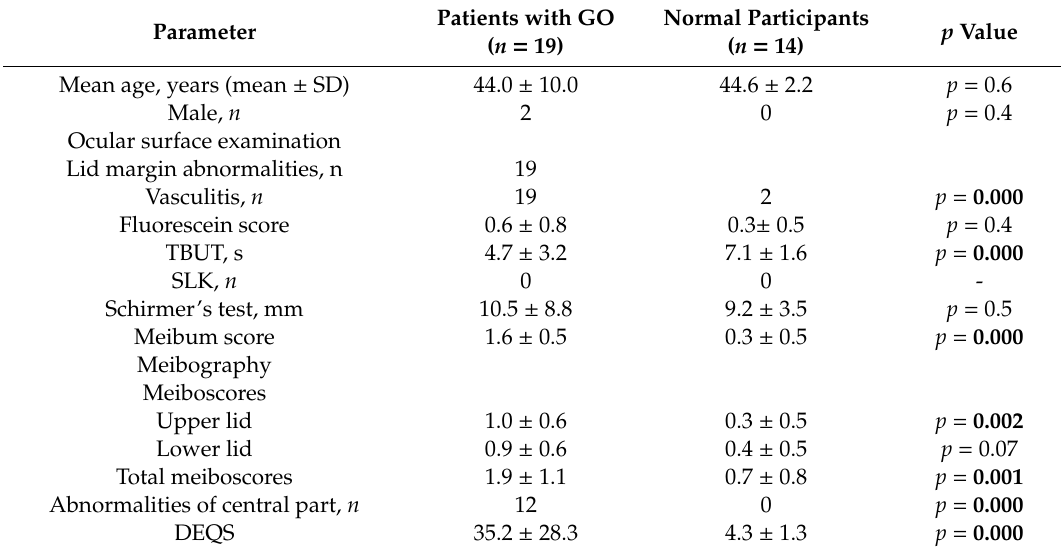
Table 2. Clinical parameters of ophthalmic